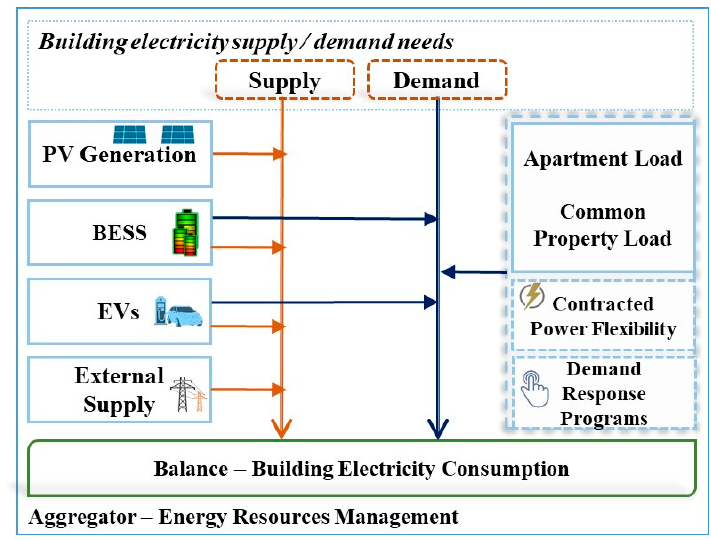
Figure 1. Methodology to support optimal energy management in the context of buildings.